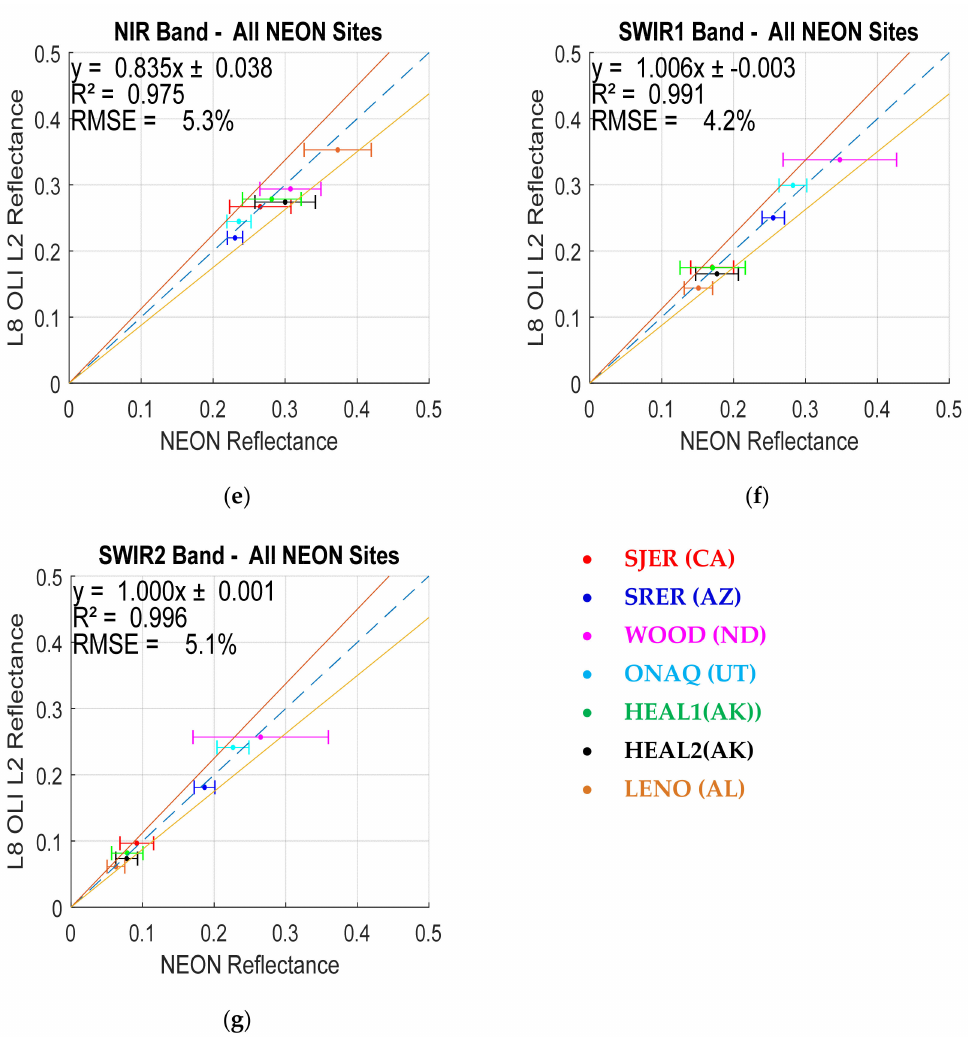
Figure 17. ( a – g ) Scatter plots of the OLI L2 SR product vs. NIS SR for the CA-SWIR2 bands. As might be expected, the validation of OLI L2 SR using NIS SR is least accurate in the VIS bands, which is indicated by the estimated RMSE estimates in the CA, Blue, and Green bands of 31.7%, 17.3%, and 9.2%, respectively. The CA and Blue band estimates do not fall within the expected ~15% product uncertainty and the majority of data points are located outside of the uncertainty region. The Green and Red bands appear to exhibit greater accuracy at all sites except for the Lenoir Landing (LENO) (AL) site, whose estimates fall outside of the expected uncertainty range in all visible bands. This is due to surface reflectance measurements of 0.05 or less, which are more sensitive to aerosol loading in the atmosphere. In the Red, NIR, SWIR1 and SWIR 2 bands, signal levels are higher. The OLI L2 product surface reflectances across all sites fall within the expected 15% uncertainty range, generally following the 1:1 trend, as shown by the lower RMSE values of approximately 7.7%, 5.3%, 4.2% and 5.1%,